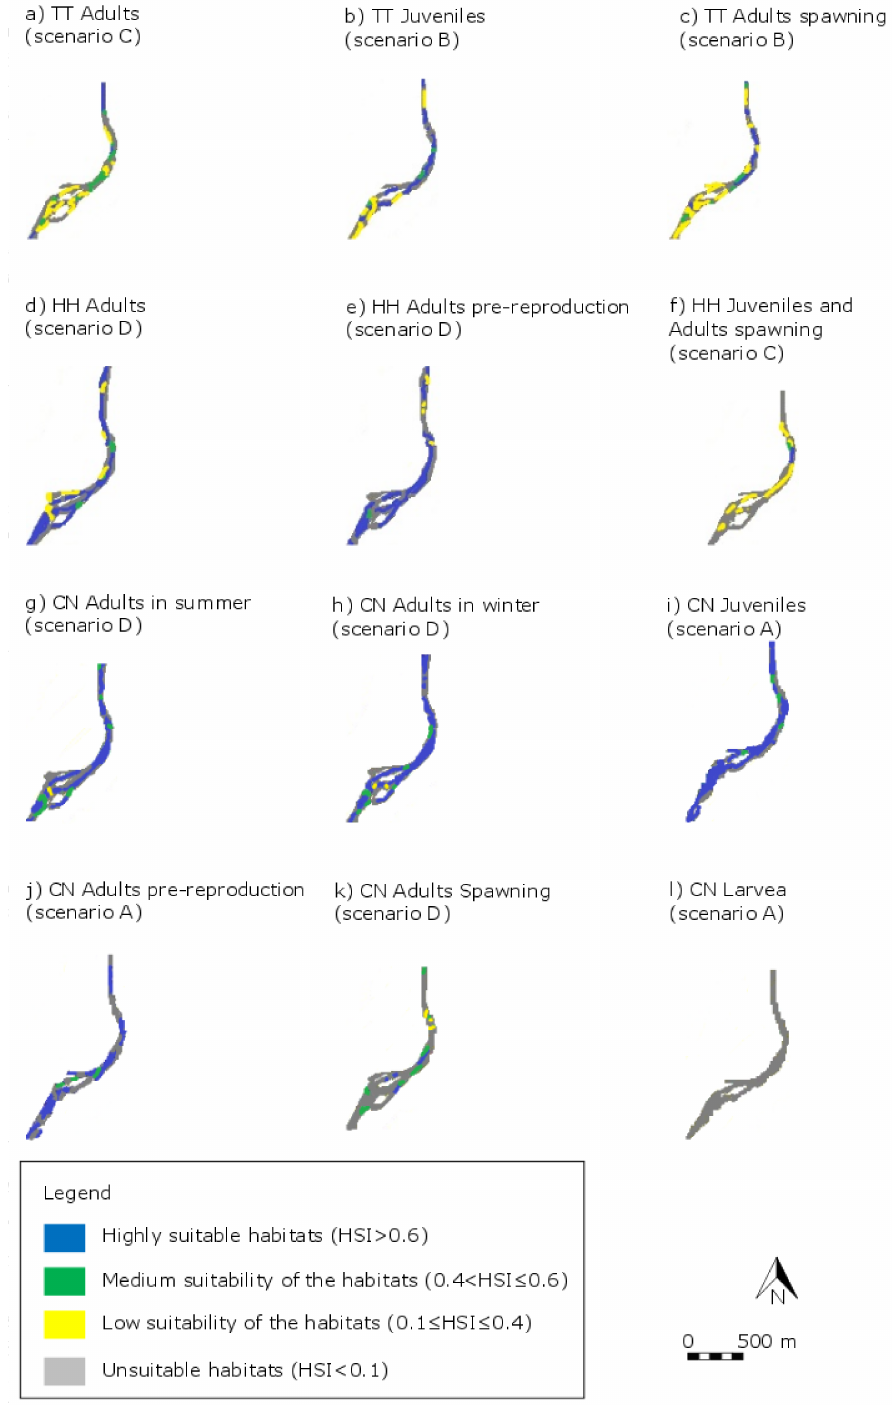
Figure 7. Extract of Habitat suitability maps of the Flaucher site. Model outputs displayed the spatial distribution of the usable area for the best scenario found while considering each habitat type of Thymallus thymallus L. ( a – c ), Hucho hucho L. ( d – f ), and Chondostroma nasus L. ( g – l ) at annual mean